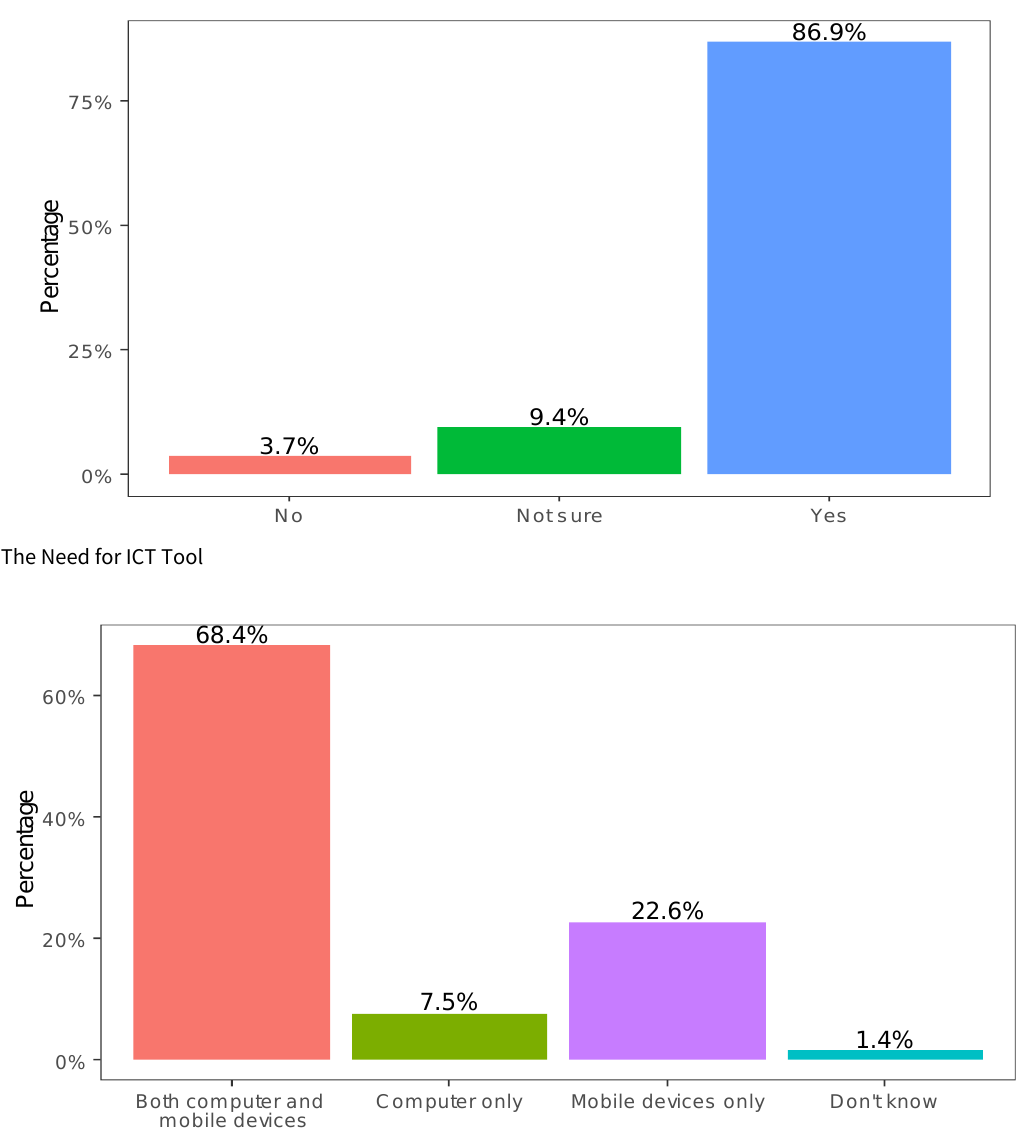
Figure 8. Students ’ Desired Device for Accessing the Proposed